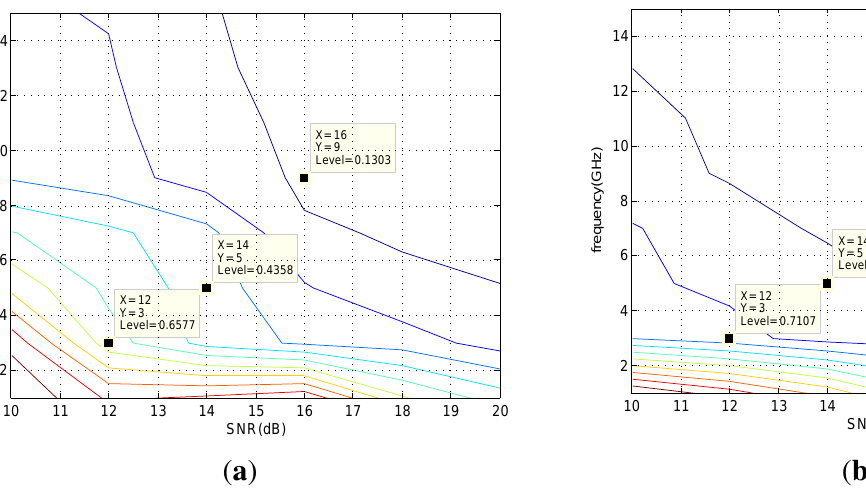
Figure 13. Comparison of RMSE of 3D array with respect to different frequency and SNR. ( a ) β = 80 ◦ ; ( b ) β = 60 ◦